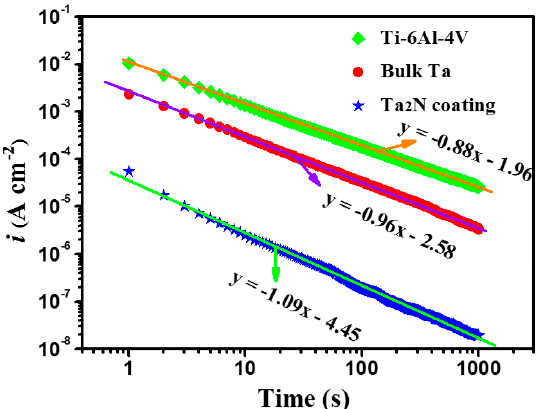
Figure 11. Double-log plots of current-time for uncoated Ti-6Al-4V, commercially pure Ta and the Ta 2 N coating potentiostatically polarizated at 0.8 V in Ringer’s physiological solution. coating potentiostatically polarizated at 0.8 V in Ringer’s physiological